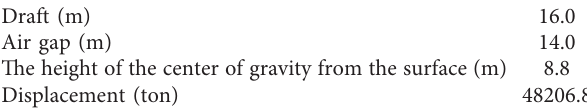
Table 2: The parameters in survival